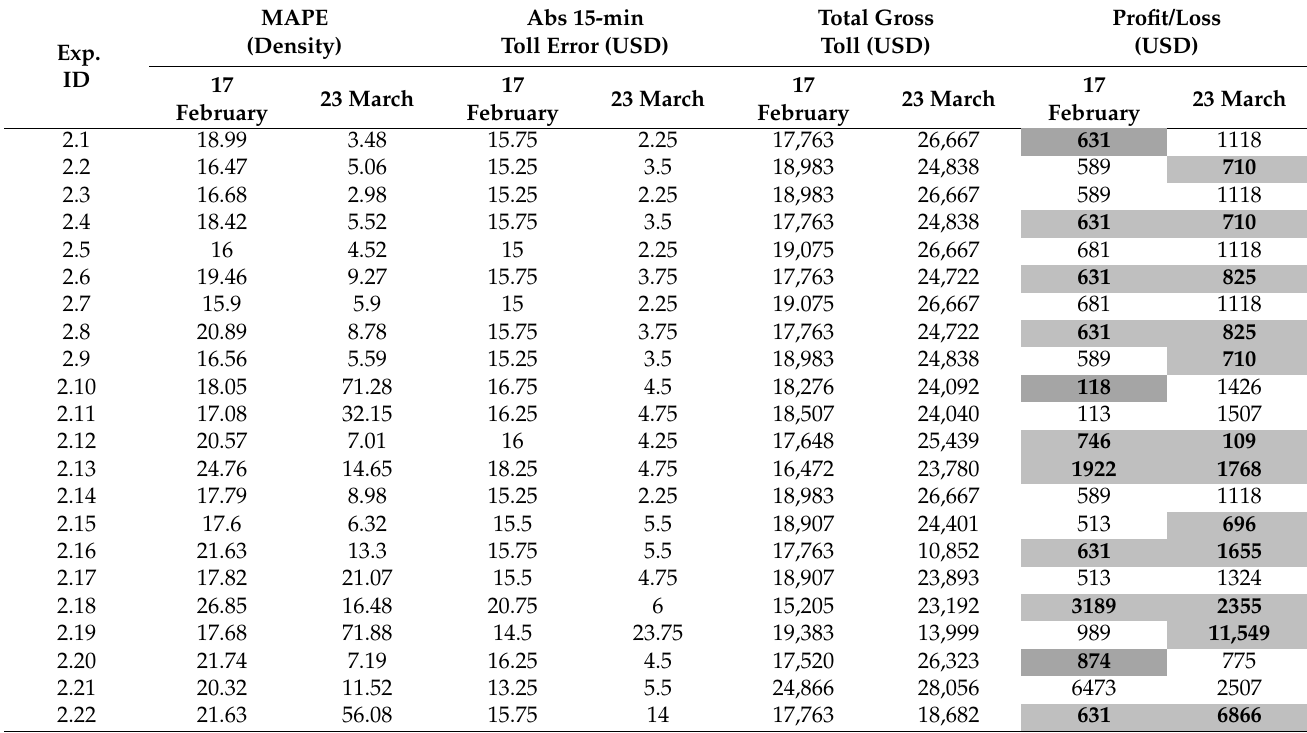
Table 5. Results of stochastic detection scenario for the Southbound